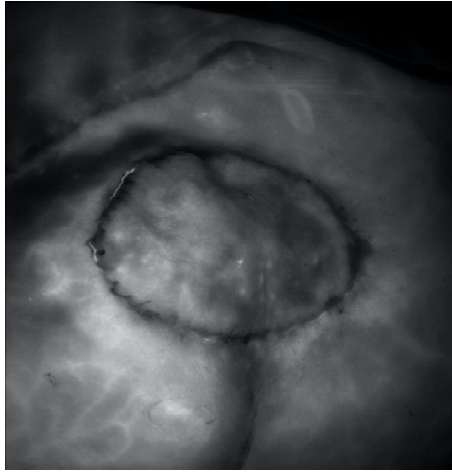
Figure 5. ICG fluorescent angiography was used to confirm a dynamic blood flow and provide a final confirmation of the perioperative posture of the perforators.